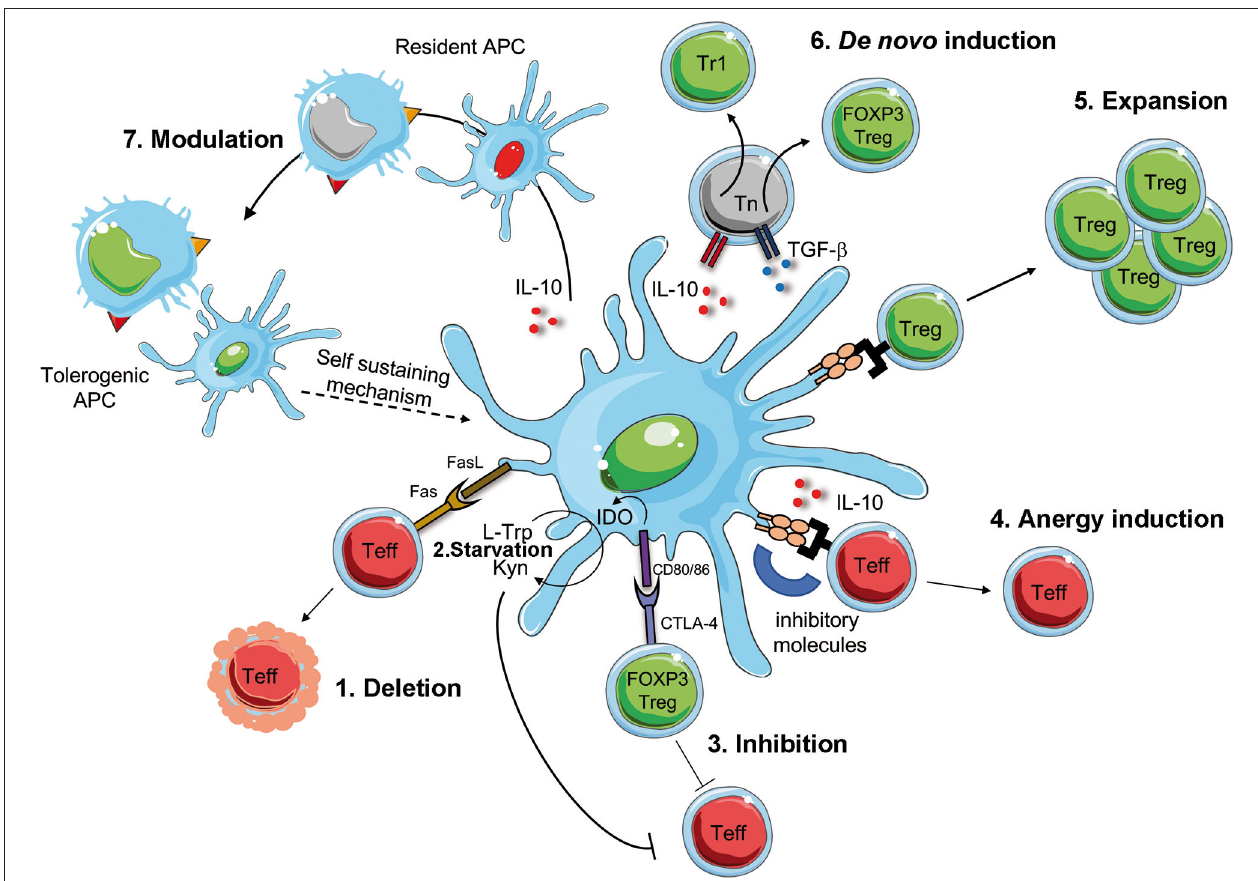
FIGURE 2 | Mechanism of DC-mediated tolerance. Tolerogenic (Tol)DC promote deletion or modulate Teff cells via Fas/FasL interaction [1], starvation of Teff cells via IDO production that degrades tryptophan (L-Trp) into kynurenine (Kyn) [2]. IDO is induced by the interaction between CD80/CD86 on tolDC and CTLA-4 on regulatory T cell (FOXP3 Treg), which concur to the suppression of Teff cells [3]. The interaction of inhibitory molecules on tolDC and Teff cells in the presence of IL-10 secretion promotes T cell anergy [4]. TolDC favor the activation and expansion of pre-existing Tregs [5] of de novo induction of FOXP3 Treg of Tr1 cells [6]. Finally, surface expression of inhibitory molecules and secretion of regulatory mediators promote the conversion of resident APCs into tolerogenic APCs, which sustain tolerance [7]. Teff, effector T cells; CTLA-4, cytotoxic T-lymphocyte antigen-4; IDO, indoleamine 2,3-dioxygenase; L-Trp, L-tryptophan, Kyn, kynurenins; Fas, first apoptosis signal; FasL, Fas